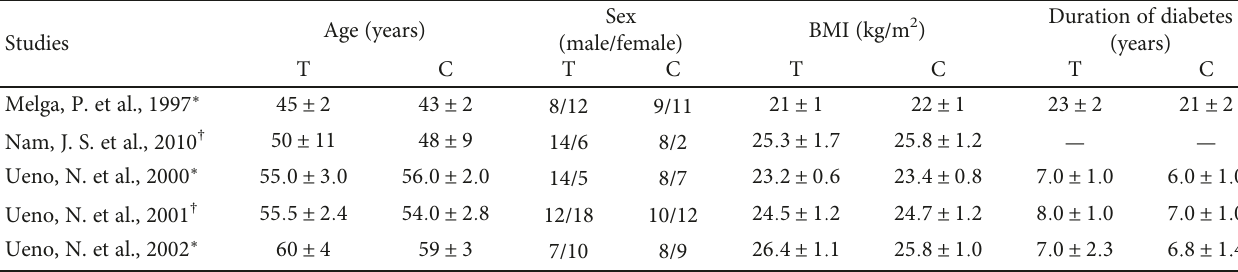
Table 2: Baseline characteristics.